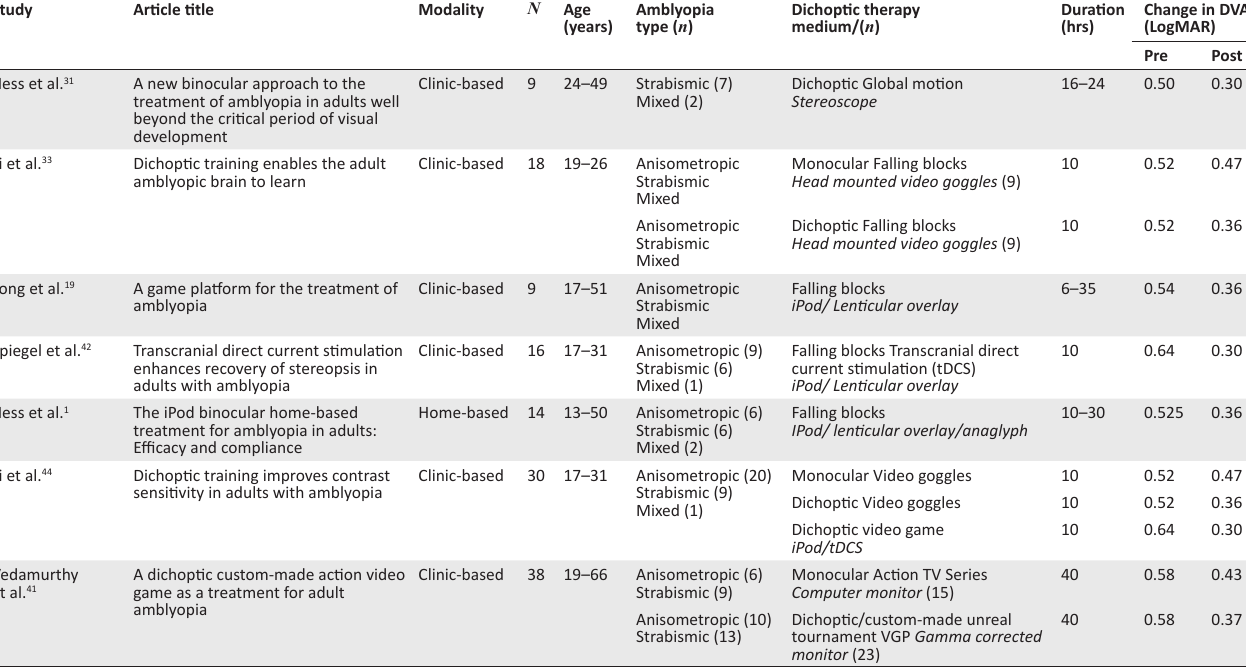
TABLE 1: Dichoptic therapy and distance visual acuity improvement in anisometropic, strabismic and mixed amblyopes.